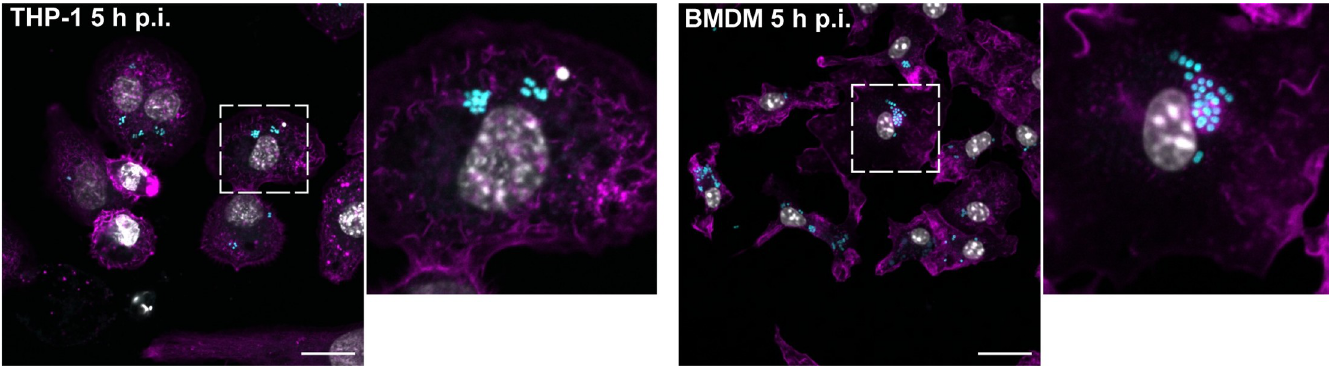
Fig 3. UPAB1 replicates in multiple host cell lines. Representative images of infected THP-1 (left panels) or BMDM (right panels) cells at 5 h p.i. Samples were stained for cell nuclei (grey), actin (magenta) and UPAB1 GFP (cyan). Insets show a higher magnification of the area indicated by the white box. Individual channels are presented in S4 Fig. Bars: 20 μ